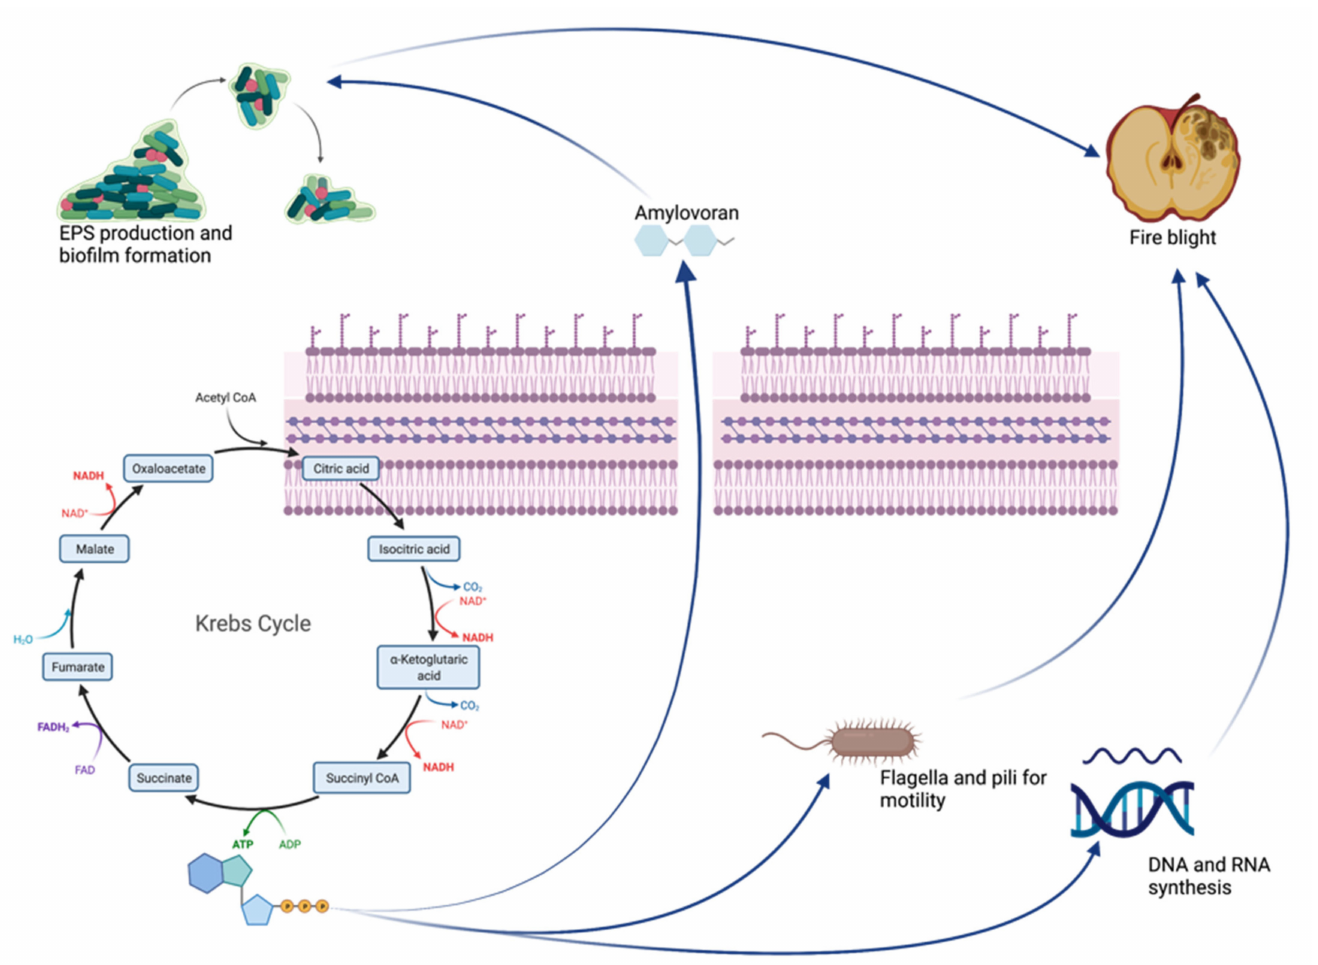
Figure 8. Fire blight pathogenesis and its main virulence factors: As previously reported, fire blight pathogenesis is strictly correlated to biofilm formation, swarming motility and EPS production. The ATP produced in the Krebs Cycle is fundamental for providing energy for all active processes within bacterial cells. Amylovoran permeabilization through the membrane results in EPS formation and biofilm